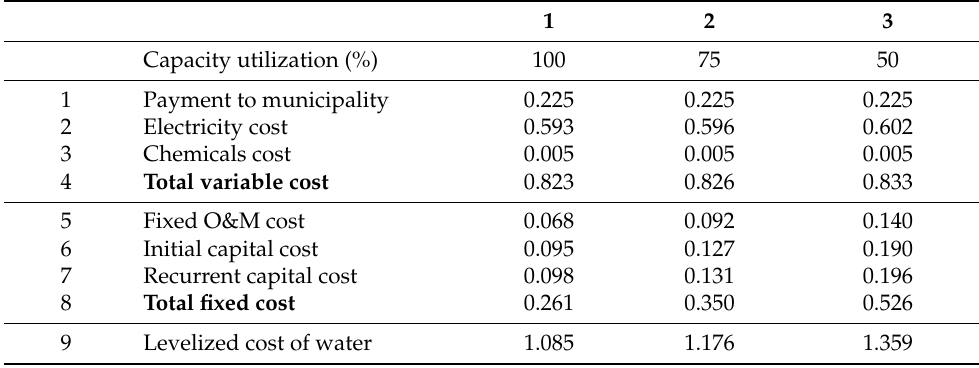
Table 3. Levelized Financial Costs per USD/m 3 of Water Produced at Different Average Capacity Levels in 2022